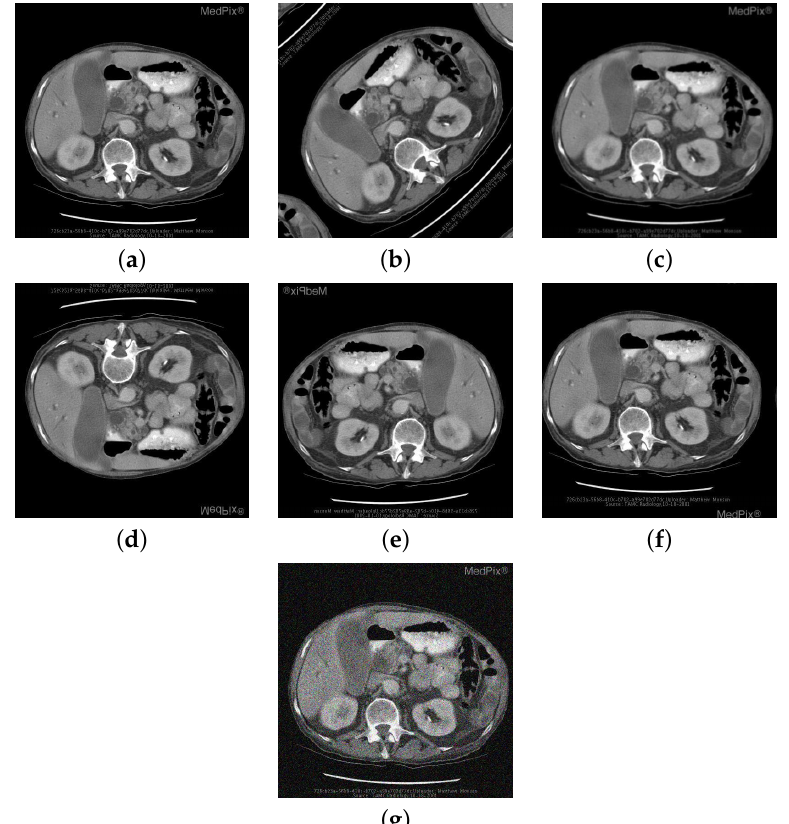
Figure 5. Examples of created images from the original image ( a ): ( b ) is the rotated image, ( c ) the blurred image, ( d ) the horizontally flipped image, ( e ) the vertically flipped image, ( f ) the shifted image, and ( g ) the noisy